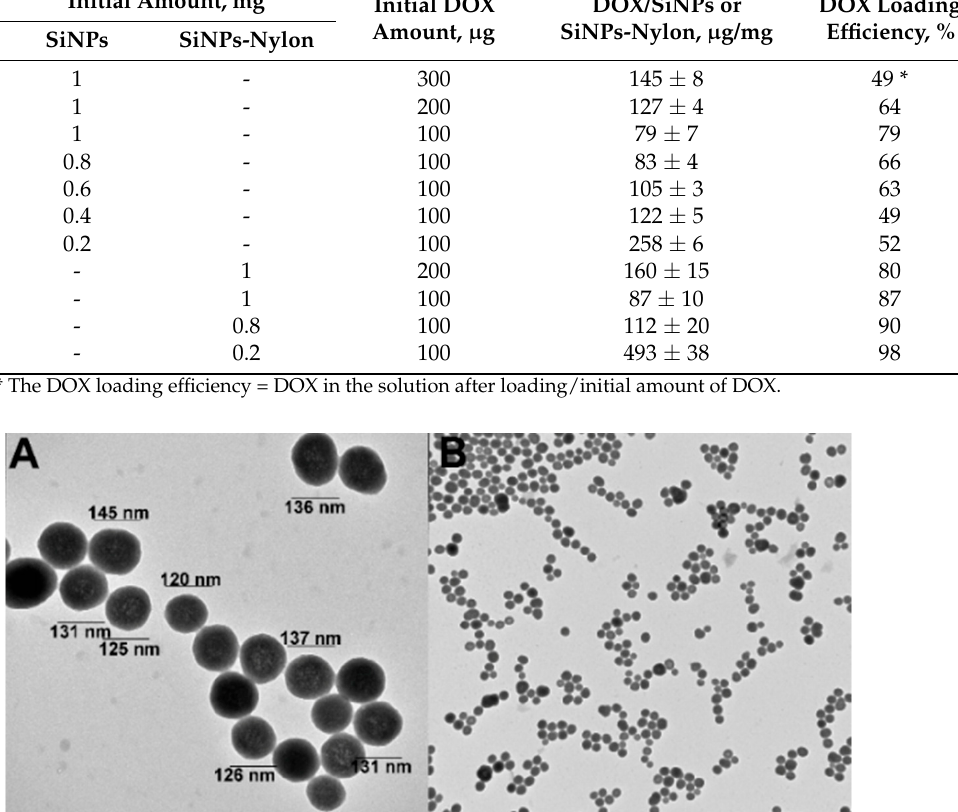
Table 3. DOX loading SiNPs and SiNPs-Nylon capacity.